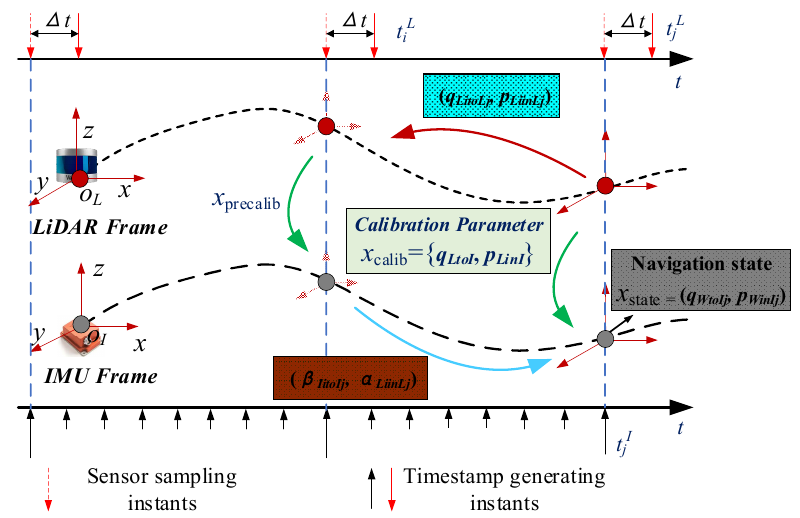
Figure 1. Multisensor spatiotemporal calibration problem description.